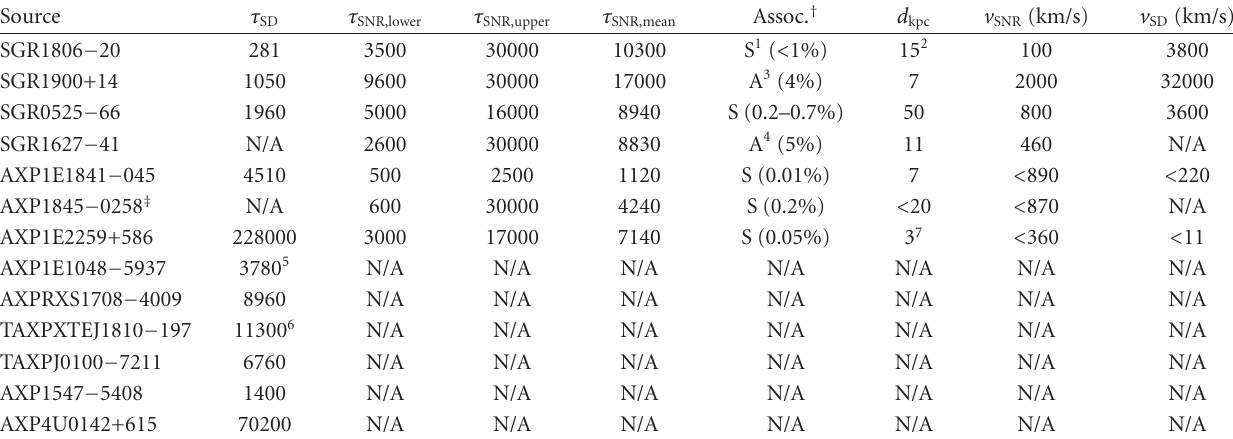
Table 1: SGRs/AXPs data mainly from Gaensler et al. [5], Marsden et al. [4], the atnf pulsar catalog [12], and Camilo [13]; with updates as indicated by footnotes. Spin-down ages, τ SD , and SNR ages, τ SNR , in years. Source τ SD τ